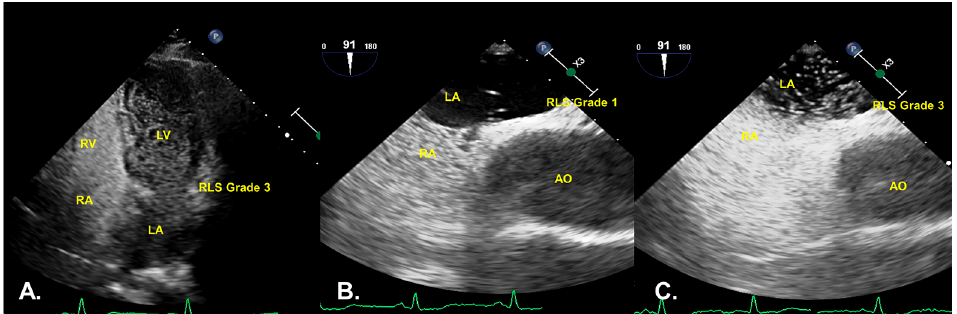
Figure 3. The grade of the PFO RLS shunt in the case of AVM cTTE ( A ), non-AVM cTEE ( B ), and AVM cTEE ( C ) in the same patient. RLS Grade 3 in AVM cTTE, RLS Grade 1 in non-AVM cTEE, RLS Grade 3 in AVM cTEE.LV, left ventricular; LA, left atrial; RA, right atrial; RV, right ventricular; AO; aorta; RLS, right-to-left shunt; PFO, patent foramen ovale; AVM, adequate Valsalva maneuver; cTTE, contrast-enhanced transthoracic echocardiography; cTEE, contrast-enhanced transesophageal echocardiography.